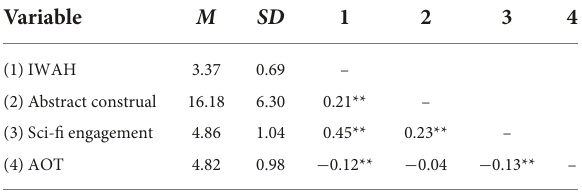
TABLE 3 Descriptive statistics and correlations of